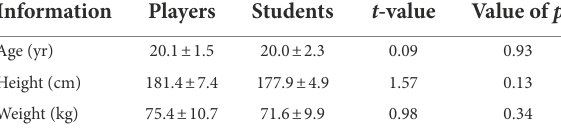
TABLE 1 Basic information of the study participants (mean ± SD). Information